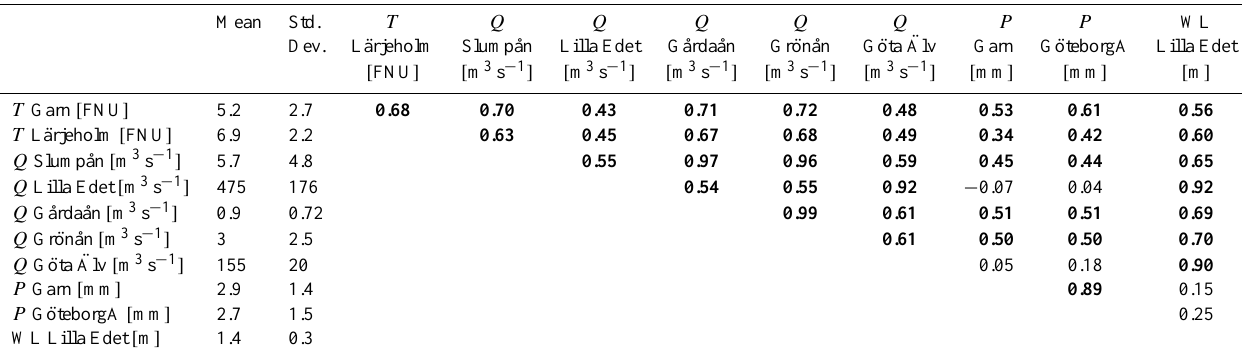
Table 4. Comparison between the main river and three of the main tributaries with respect to turbidity ( T ), flow ( Q ), precipitation ( P ) and water level (WL). The table shows data on mean and standard deviation, as well as correlation data for the variables T , P and Q (2004–2006). Correlation in 864 bold is significant at p < 0.05.